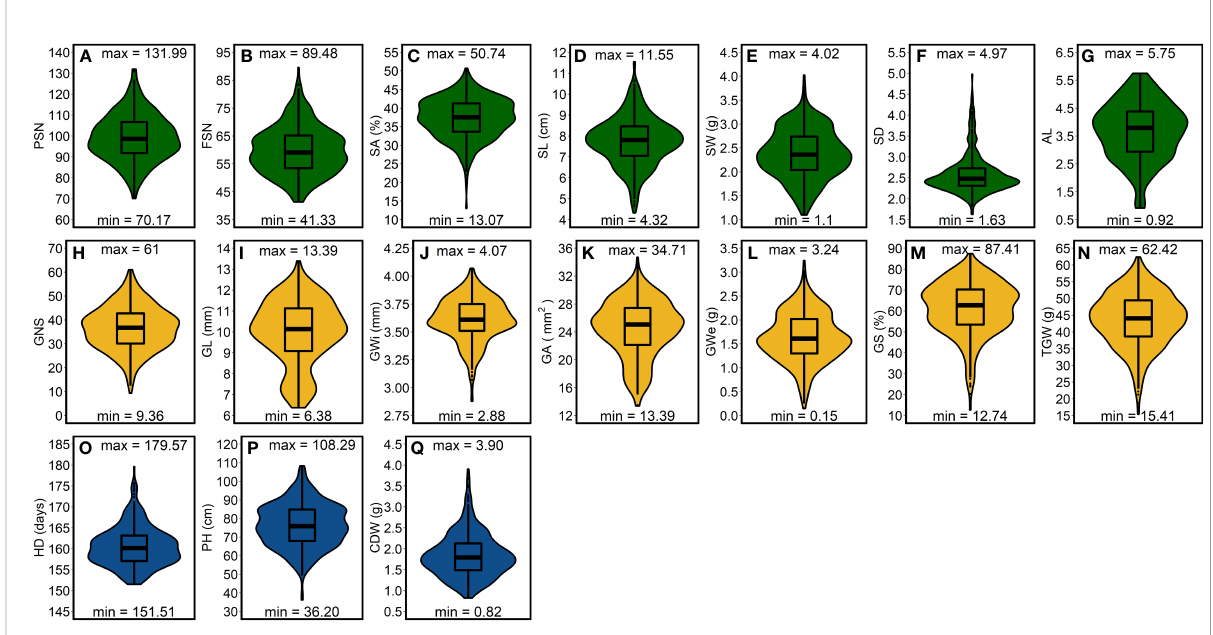
FIGURE 2 Phenotypic distribution of the investigated traits in a panel of 417 six-rowed spring barley accessions. (A-G) frequency distribution for the spike traits, (H-N) frequency distribution for grain traits and (O-Q) frequency distribution for shoot traits. “ max ” and “ min ” represents the maximum and minimum value for each investigated trait and the box plot within the violin plots represents the lower quartile, median and upper quartile for each trait. PSN = potential spikelet number; FSN = fi nal spikelet number; SA = spikelet abortion (SA in %); SL = spike length (in cm); SW = spike weight (in g); SD = spike density; AL = awn length; GNS = grain number per spike; GL = grain length (in mm); GWi = grain width (in mm); GA = grain area (in mm 2 ); GWe = grain weight per spike (in g); GS = grain set (in %); TGW = thousand-grain weight (in g); HD = heading date (in days from January 1 st ); PH = plant height (in cm) and CDW = culm dry weight (in